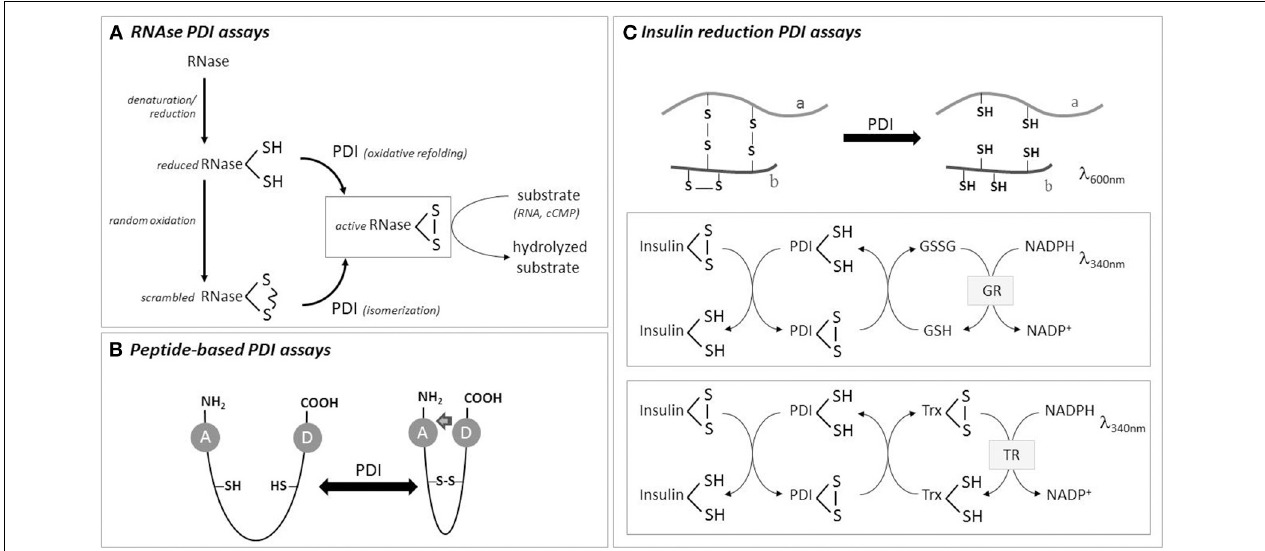
FIGURE 1 | Scheme of some PDI activity assays. (A) RNase with scrambled thiols can be used as initial substrate for PDI isomerase assay, while totally reduced RNAse is used for PDI-mediated oxidative refolding assay. RNase gain-of-activity is measured by hydrolysis of its substrates, namely RNA or cyclic CMP. (B) Peptides can be used for oxidase, reductase or isomerase PDI assays, based on energy transfer